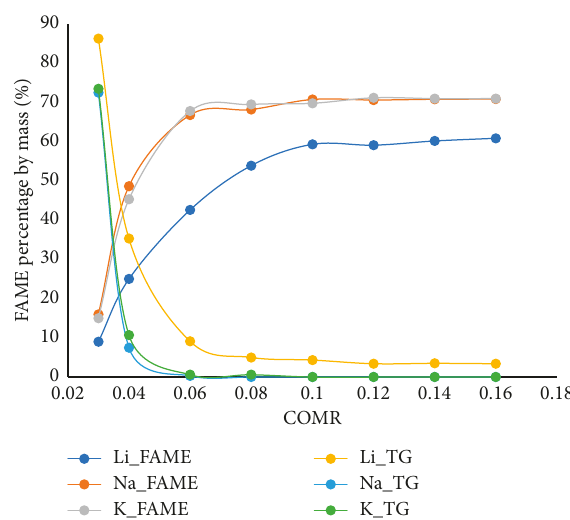
Figure 1: Plots of FAME and TG percentage by mass versus Table 1: The main components of reaction mixtures by using different COMR values of catalysts. COMR